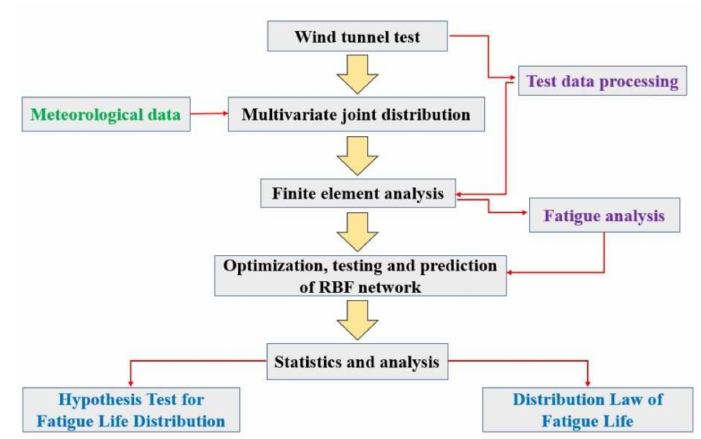
Figure 1. Research process.